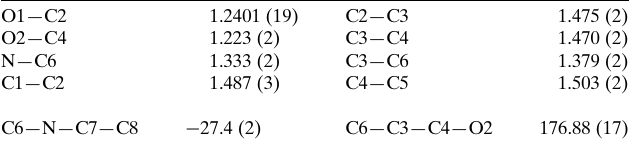
Table 3 Selected geometric parameters (A˚ , (cid:3) ) for 3